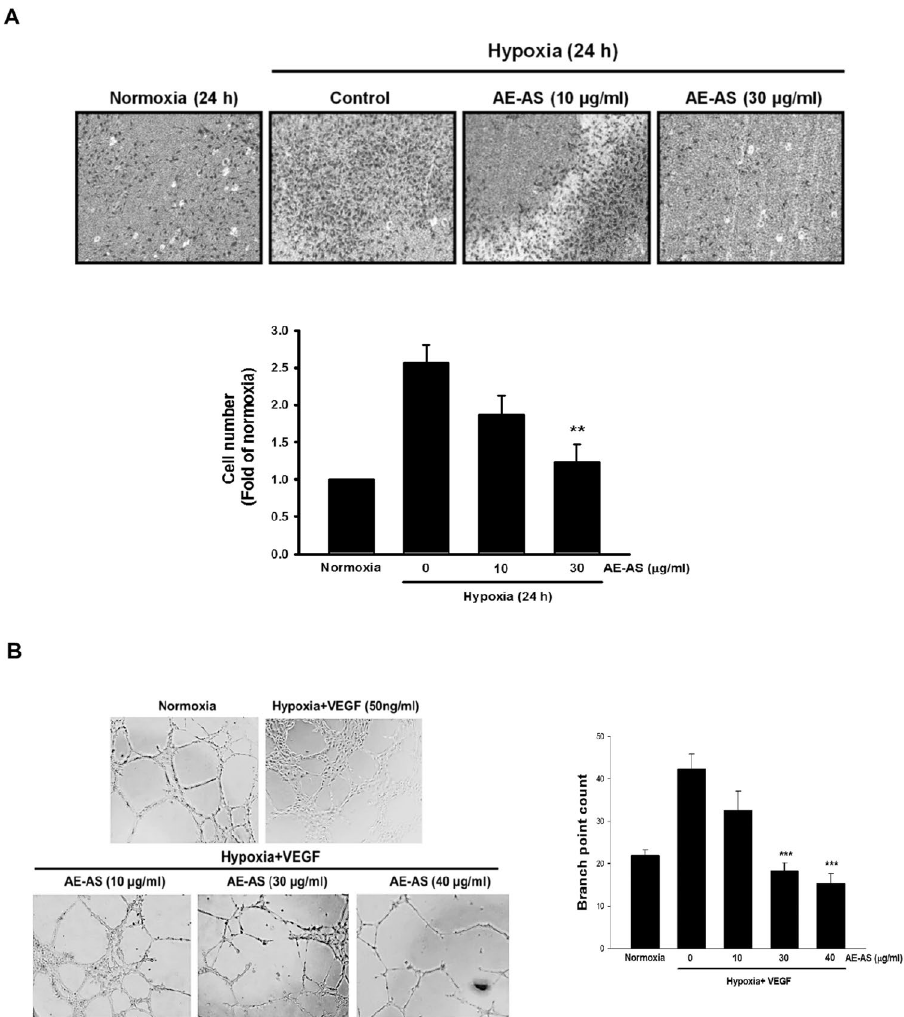
Figure 4. AE-AS inhibited the migration of T24 cells and the tube formation of HUVECs. The migration of hypoxic T24 cells ( A ) and the capillary-like tube formation in HUVECs in the presence of hypoxia and VEGF ( B ) in different groups were determined. Data was expressed as mean ± SEM (n = 5). In the migration tests: ** P < 0.01 versus hypoxia-treated alone group. In the tube formation assay: *** P < 0.001 versus hypoxia + VEGF-treated alone